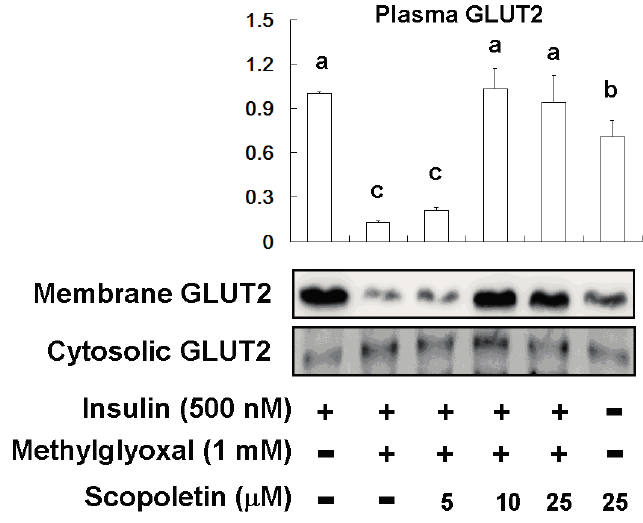
Figure 8. The effects of scopoletin (SP) on plasma translocation of GLUT2 in MG-induced FL83B hepatocytes. Data were shown as mean ± SD ( n = 3). (a–c) indicate statistically significant differences p <